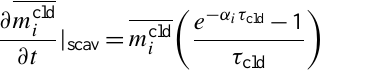
Fig. 1. The observational datasets consist of hourly measure- ments from METAR, SYNOP, AWOS and ASOS